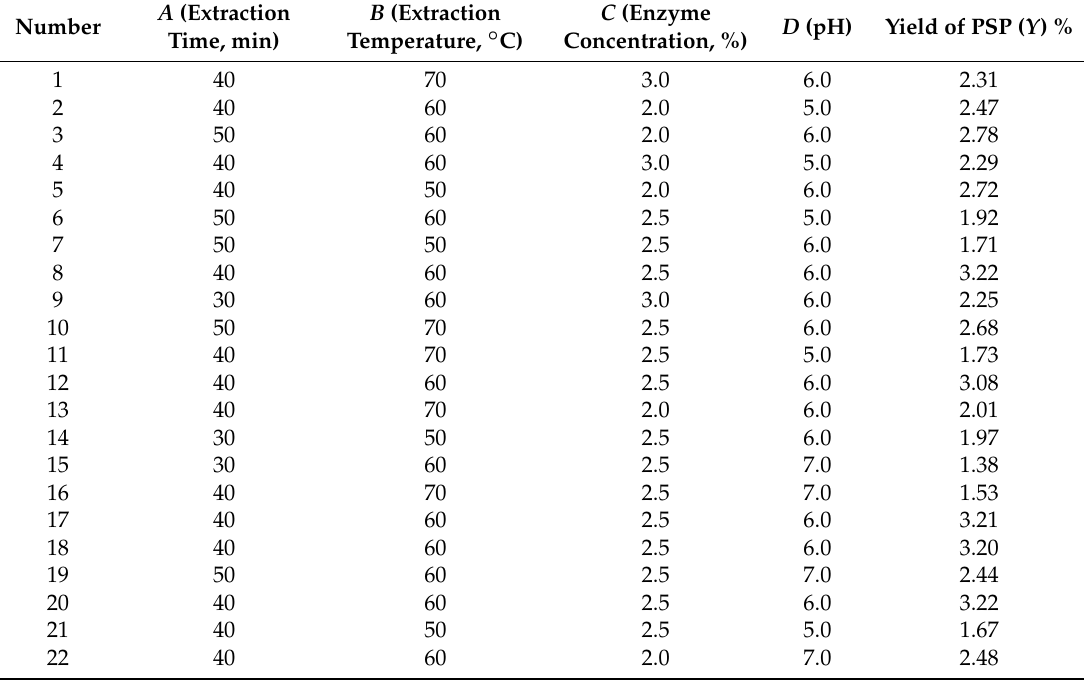
Table 2. Box-Behnken design and observed